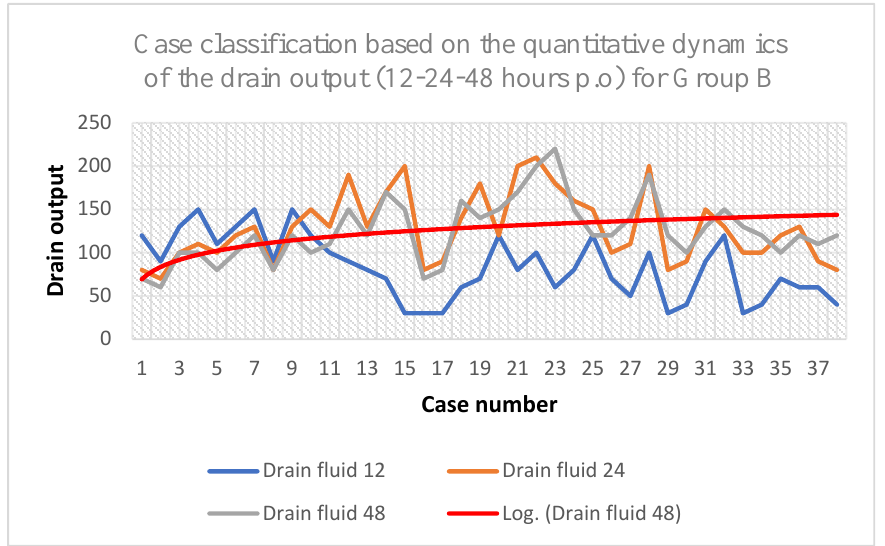
Figure 4. Quantitative dynamics of the drain output during the first 48 h for Group B.